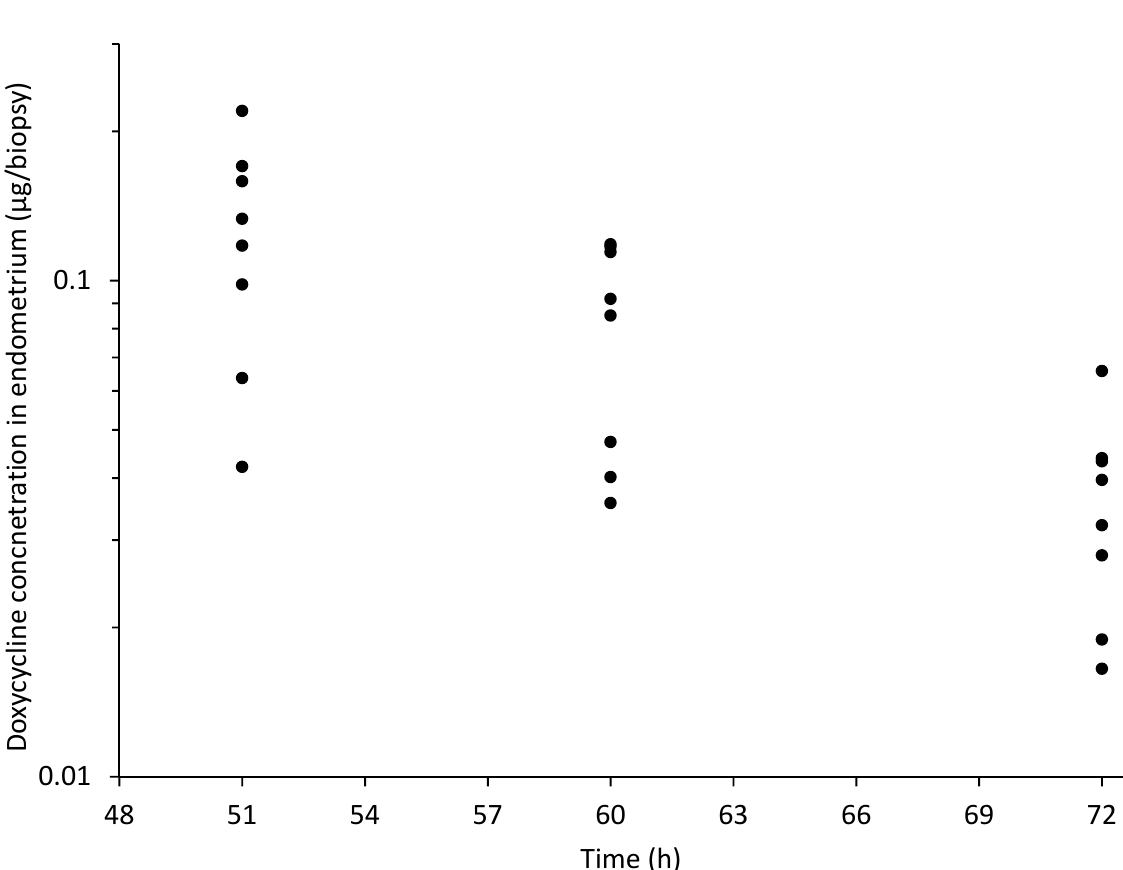
Figure 7. Individual concentration of doxycycline in endometrium biopsy vs. time following intragastric administration of doxycycline at 10 mg/kg q12 h from 0 to 48 h in 8 healthy jennies. Each solid circle represents the value from one jenny at each time point.